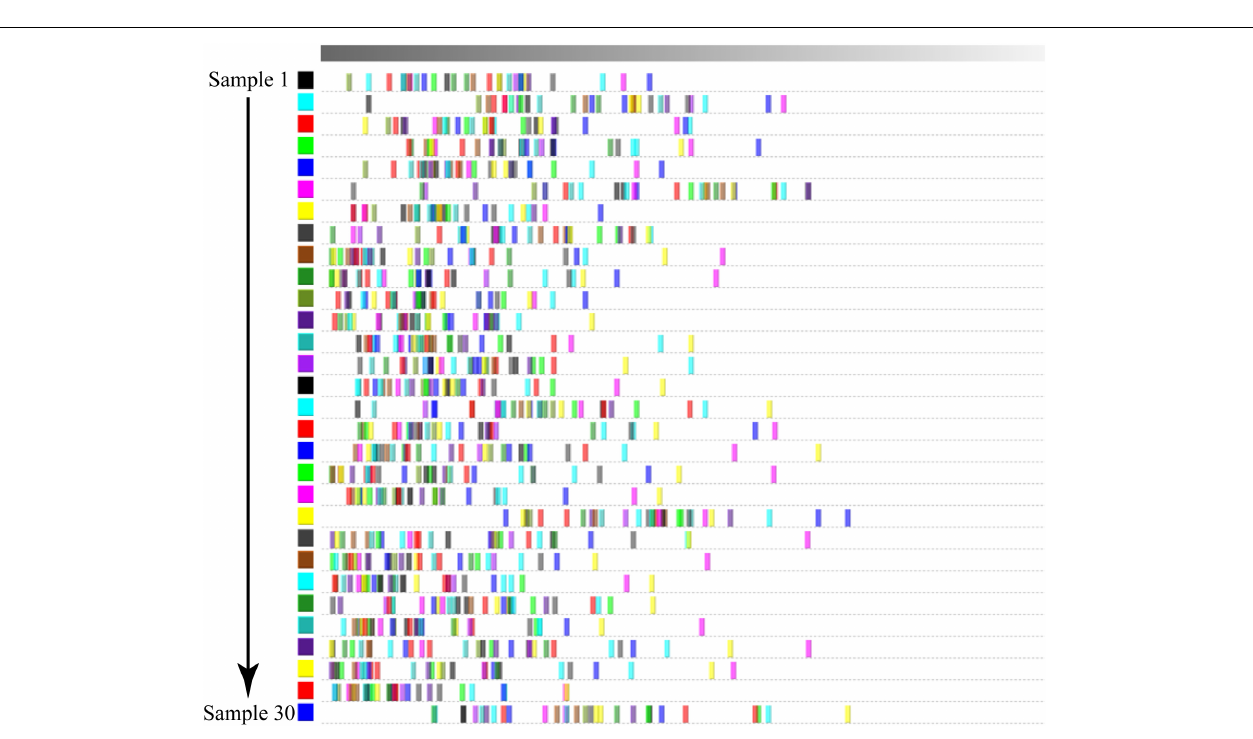
FIGURE 6 | Similarity analysis of volatile components in different Dongxiang tribute